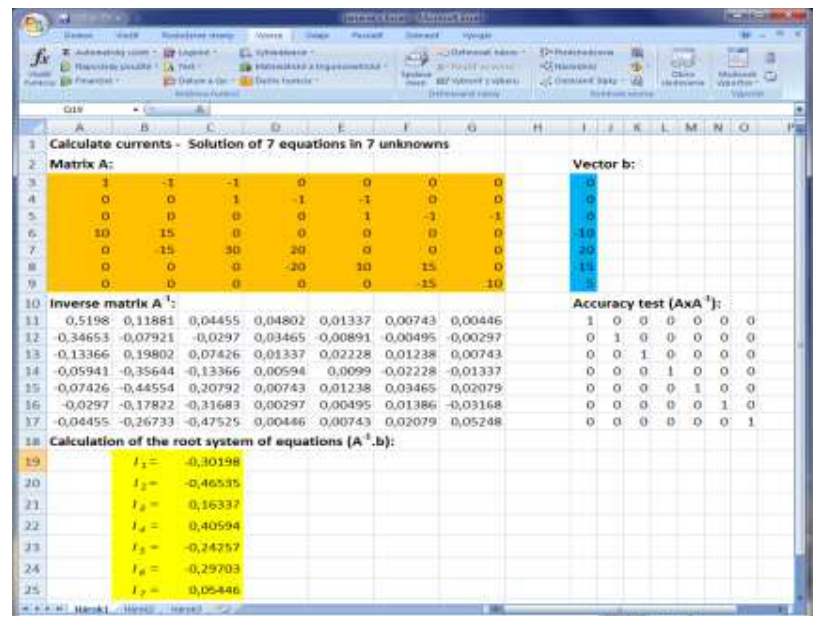
Fig. 2. Numerical solution of the set of equations in MS